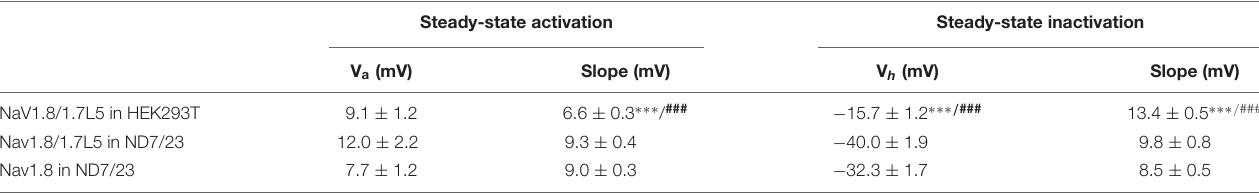
FIGURE 4 | Effect of MrVIB on NaV1.8/1.7L5. (A) 100 nM MrVIB completely blocked the currents of DRG TTX-R NaVs, NaV1.8/1.7L5 expressed in HEK293T cells and NaV1.8 expressed in ND7/23 cells, and 100 nM MrVIB inhibited the currents of NaV1.4, NaV1.5, and NaV1.7 by 65.6 ± 2.1%, 37.4 ± 2.6%, and 34.8 ± 4.6%, respectively, n = 5 – 8. (B) Dose-response curves for MrVIB blocking channels as shown. Apparent IC 50 values were determined as 26.9 ± 1.3 nM for NaV1.8/1.7L5, 27.9 ± 2.9 nM for NaV1.8, 49.3 ± 2.3 nM for DRG TTX-R NaVs, 65.1 ± 3.5 nM for NaV1.4, 127.8 ± 6.3 nM for NaV1.5 and 142.1 ± 10.0 nM for NaV1.7, respectively. n = 5 – 8. (C) MrVIB did not significantly alter the steady-state activation and inactivation kinetics of NaV1.8/1.7L5 ( n = 6 – 8). Unless otherwise indicated, data were presented as MEAN ± SEM. TABLE 1 | Fitting parameters of steady-state activation and inactivation curves of NaV1.8/1.7L5 and